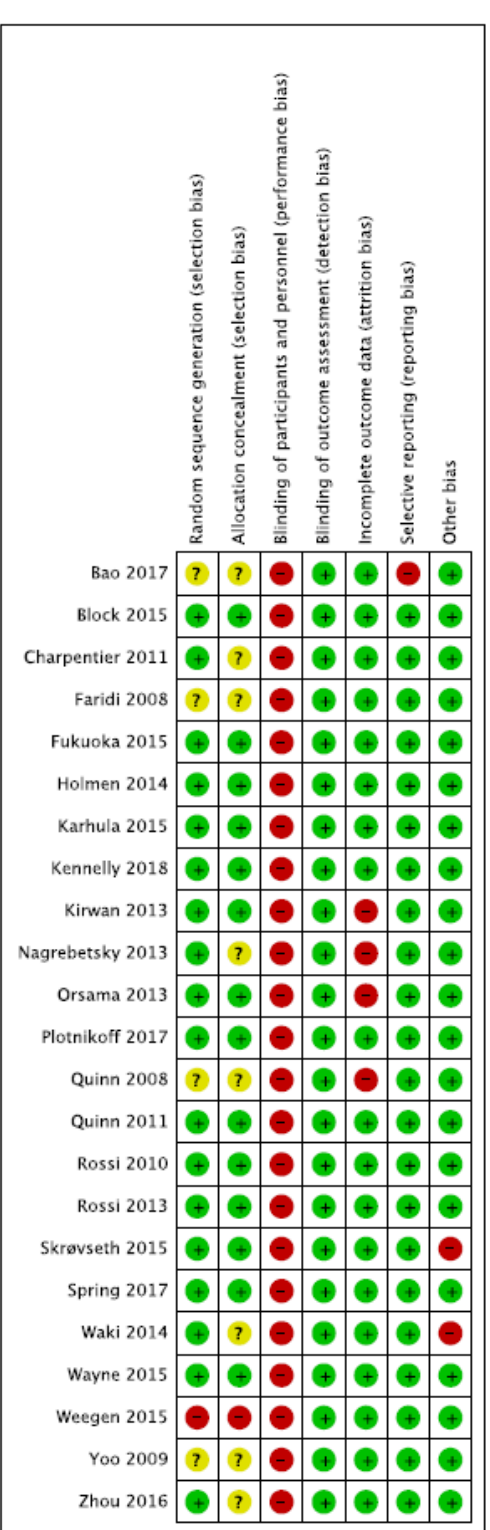
Figure 2. Risk of bias in each study. Green: low risk of bias; yellow: unclear risk of bias; red: high risk of